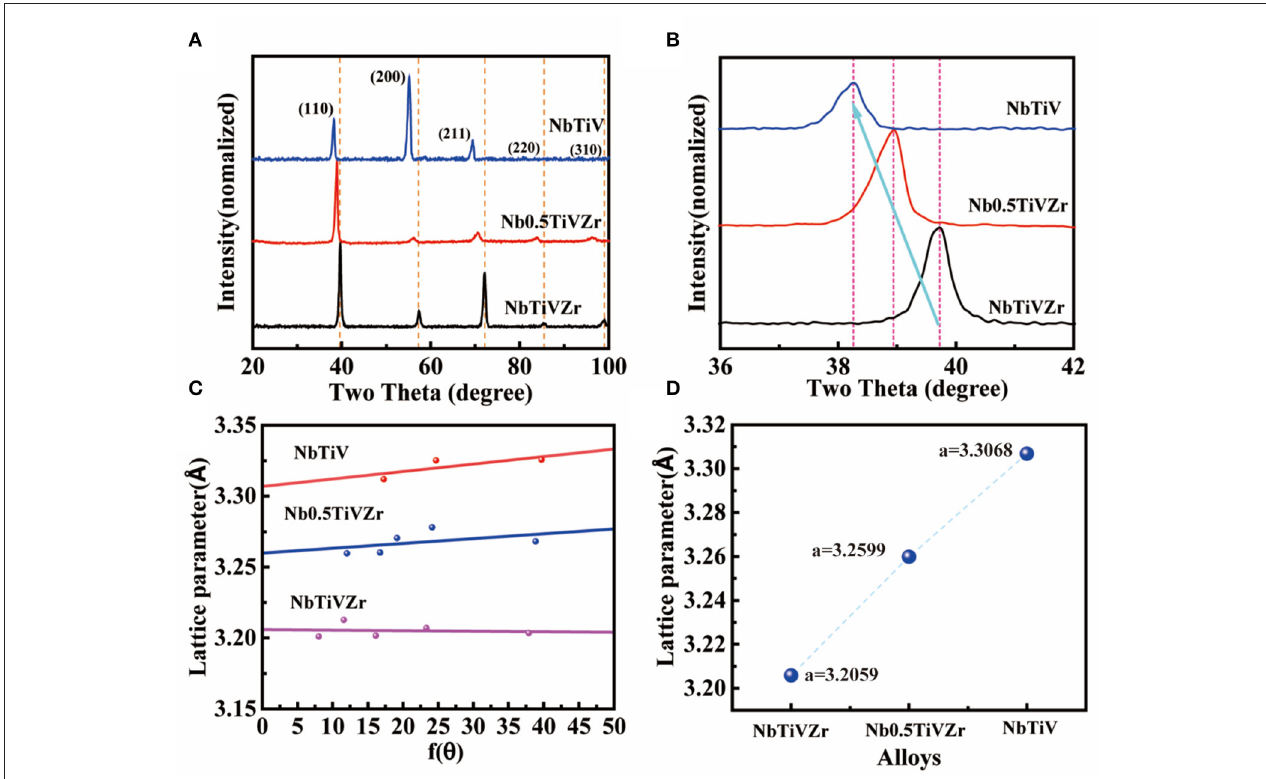
FIGURE 1 | The XRD patterns and lattice parameter of NbTiVZr, Nb0.5TiVZr, and NbTiV alloys. (A) 20 ◦ -100 ◦ , (B) 36 ◦ -42 ◦ , (C) the relation between the a values and f ( θ ), and (D) the a values of the three